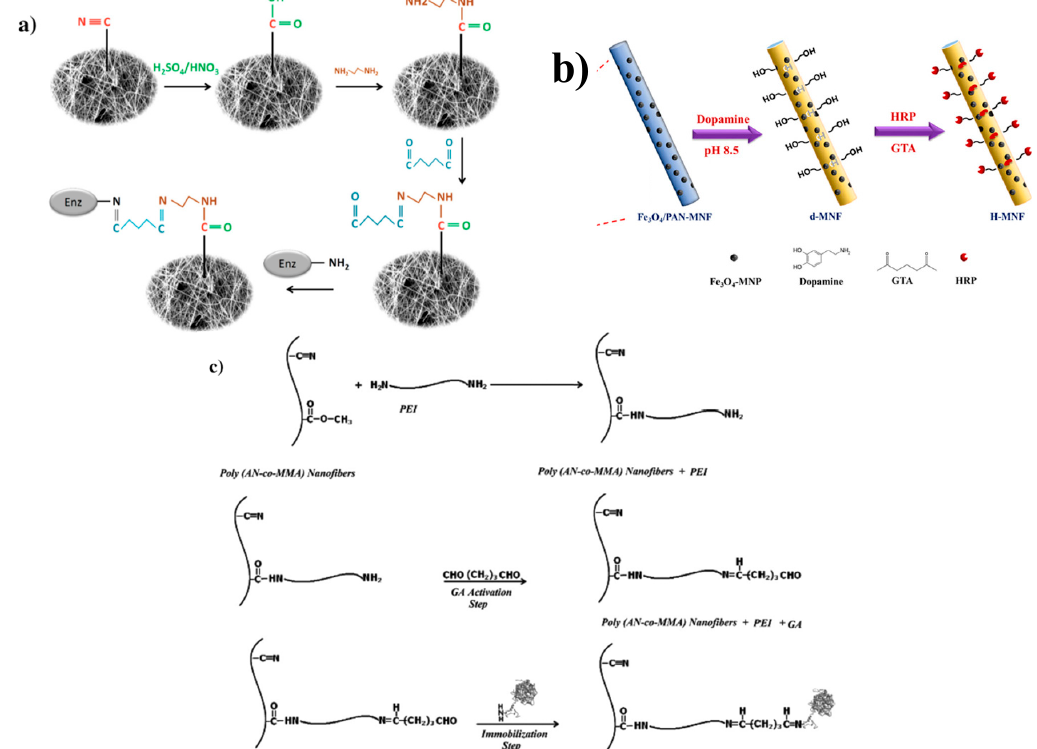
Figure 14. Schematic of the various surface functionalizations that can be performed on nanofibers before surface activation using glutaraldehyde. ( a ) Surface coating [35]; ( b ) Treatment with NaOH and HNO 3 /H 2 SO 4 [160] (Reprint with permission from Elsevier); ( c ) polymer grafting [159] (Reprint with permission from John Wiley & Sons, Inc.).